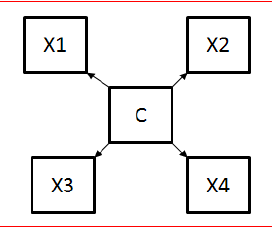
Figure 9. Diagonal directions including top left, top right, bottom left, and bottom right.